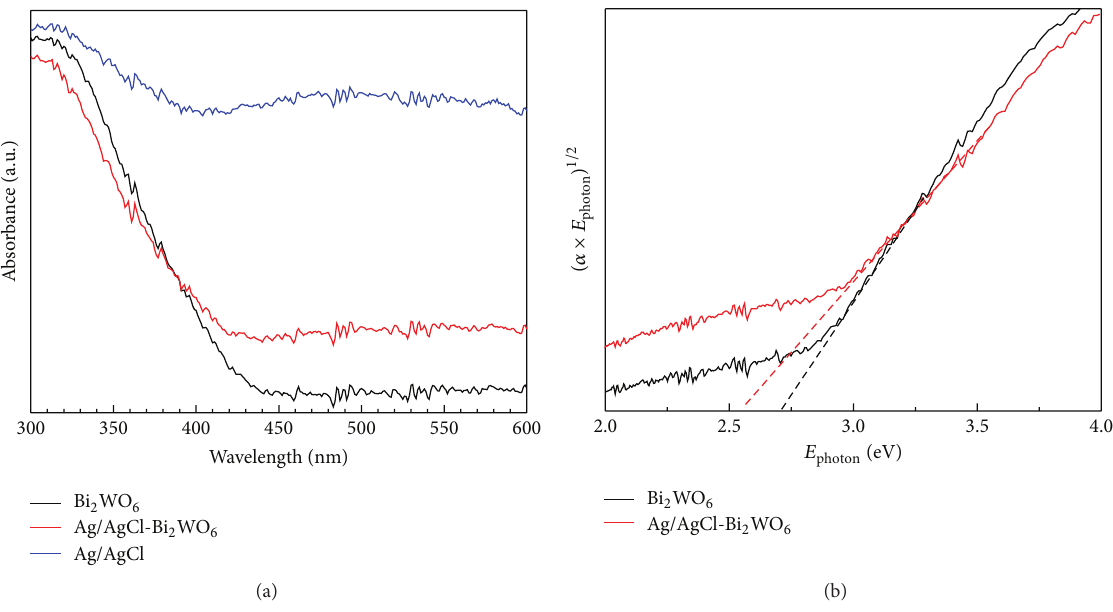
Figure 6: (a) UV-Vis diffused reflectance spectra and (b) (𝛼𝐸 photon ) 1/2 - 𝐸 photon curves of as-prepared pure Bi 2 WO 6 , Ag/AgCl, and Ag/AgCl (10wt%)-Bi 2 WO 6 .